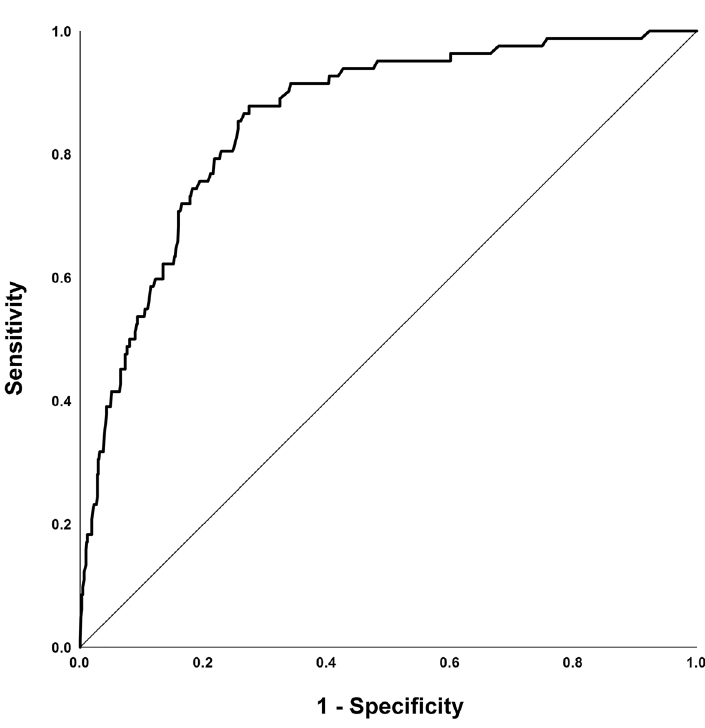
Figure 2. The performance of the nomogram in the training set was measured using the area under the receiver operating characteristic curve (AUC). AUC of the training set: 0.856 (95% confidence interval, 0.815 to